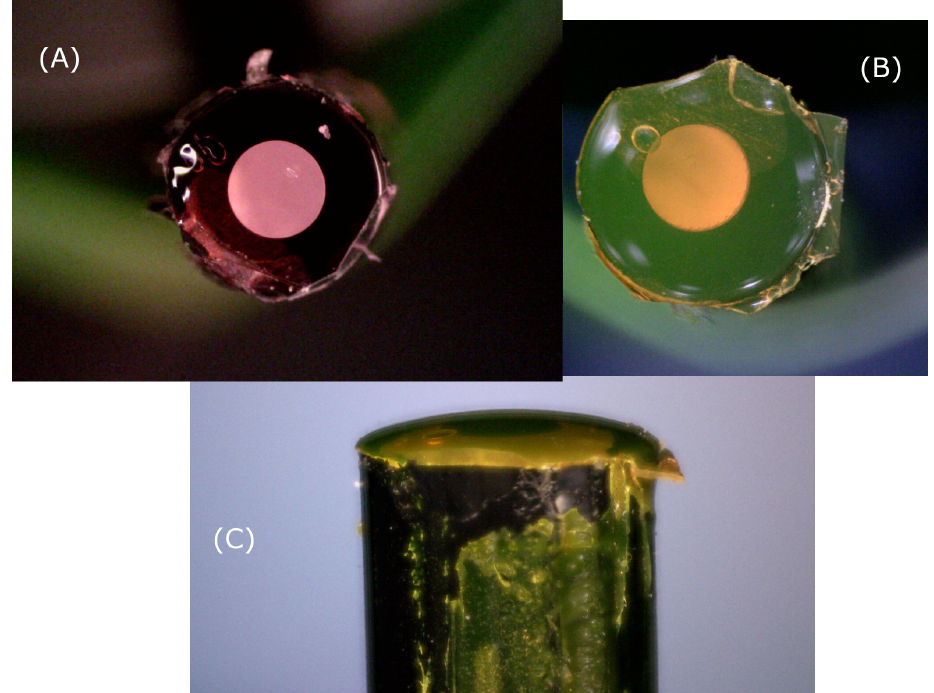
Figure 6. Fiber sensors manufactured by the process of applying a thin film consisting of a PMMA matrix, containing either PtOEP or PtOEP+C545T, at the distal end surface. In ( A ) the fiber is with only PtOEP, while ( B , C ) are with a mixture of C545T and PtOEP. The fibers, with jacket, are 2.2mm in diameter, with a core and cladding of approximately 1mm. After 16 hours of drying the film thicknesses are on the order of